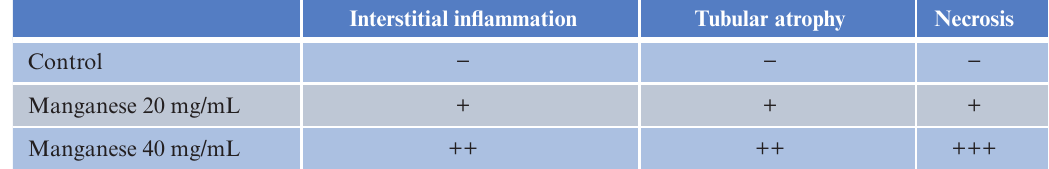
Table 3. Renal tissue histopathological alterations in manganese-exposed